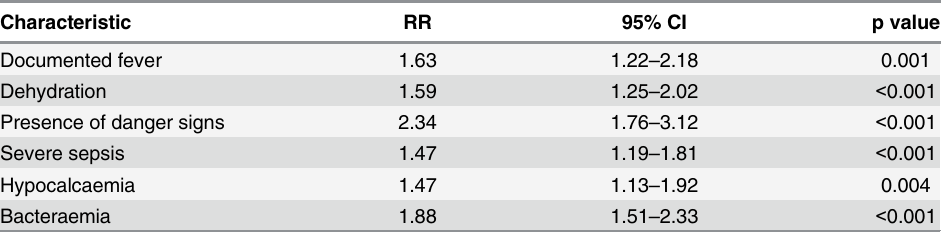
Table 4. Results of log-linear binomial regression, to identify independent risk factors for treatment failure in SAM children presenting with cough or respiratory difficulty and radiological pneumonia and who received standard WHO